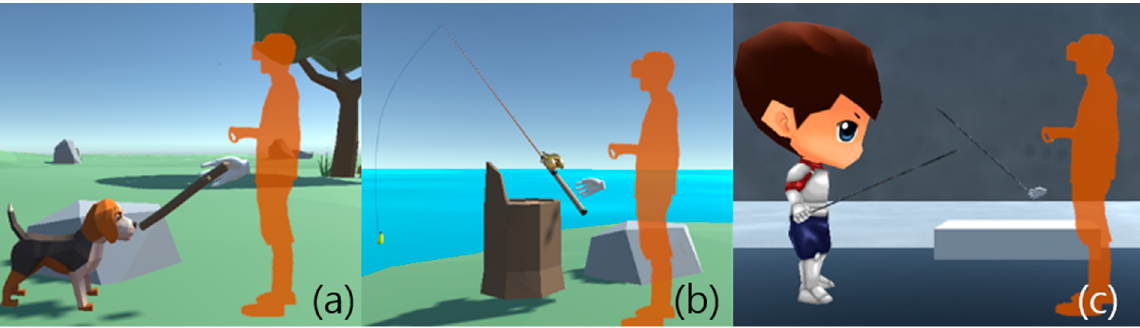
Figure 6. Three content types for experiencing haptics: ( a ) a dog tug game, in which the user feels that the tool is pulled out of the hand due to interaction with an object; ( b ) a fishing game, in which centrifugal force can be felt when swinging the tool; and ( c ) a fencing game, in which the user feels the tool pushed into the hand due to interaction with an object.